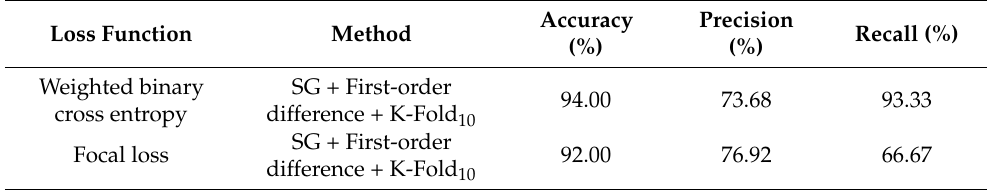
Table 10. Comparison of